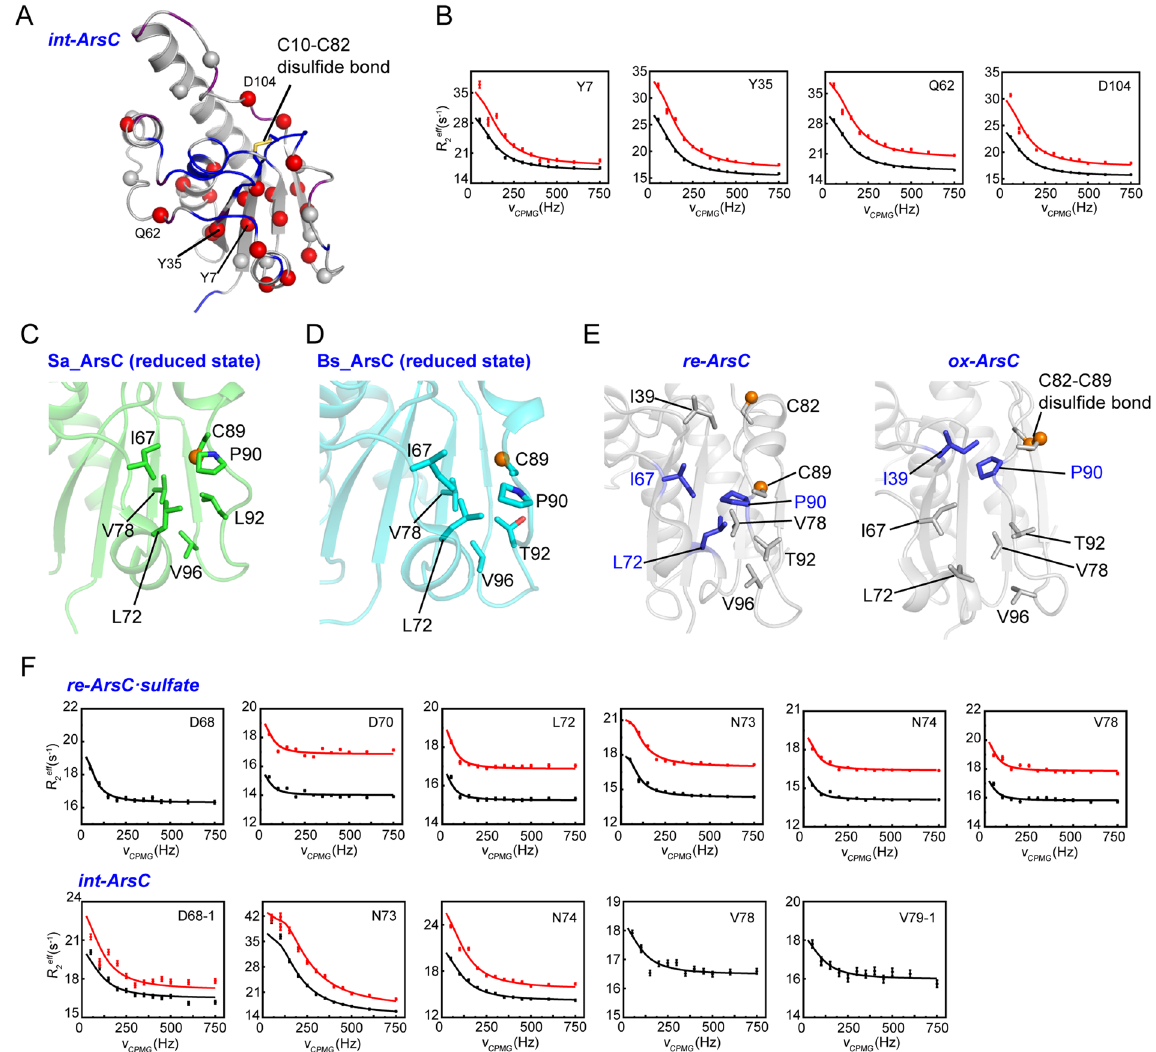
Figure 4. CPMG RD results of int-ArsC . ( A ) Mapping of residues showing conformational exchanges in int-ArsC identified by CPMG RD experiments onto the structure model (shown as spheres). Residues with missing backbone amide resonances are colored blue, and residues with weak signals are colored purple. ( B ) Representative RD profiles of residues in int-ArsC obtained on 600-MHz (black) and 800-MHz (red) spectrometers. ( C , D ) The local conformation of the hydrophobic pocket that C89 occupies in the reduced state of Sa_ArsC ( C , PDB code: 1ljl) and Bs_ArsC ( D , PDB code: 1z2d). ( E ) Comparison of the local structural changes of the hydrophobic pocket in re-ArsC and ox-ArsC showing the packing of P90 either with I67, I72 in re-ArsC (left) or with I39 in ox-ArsC (right). ( F ) Representative RD profiles of residues in the 70 s segment in re-ArsC·sulfate (upper panel) and int-ArsC (lower panel) obtained on 600-MHz (black) and 800-MHz (red) spectrometers. The data for D68 in re-ArsC·sulfate and V78 and V79 in int-ArsC obtained at B 0 field of 800 MHz were excluded from analysis due to relatively large experimental